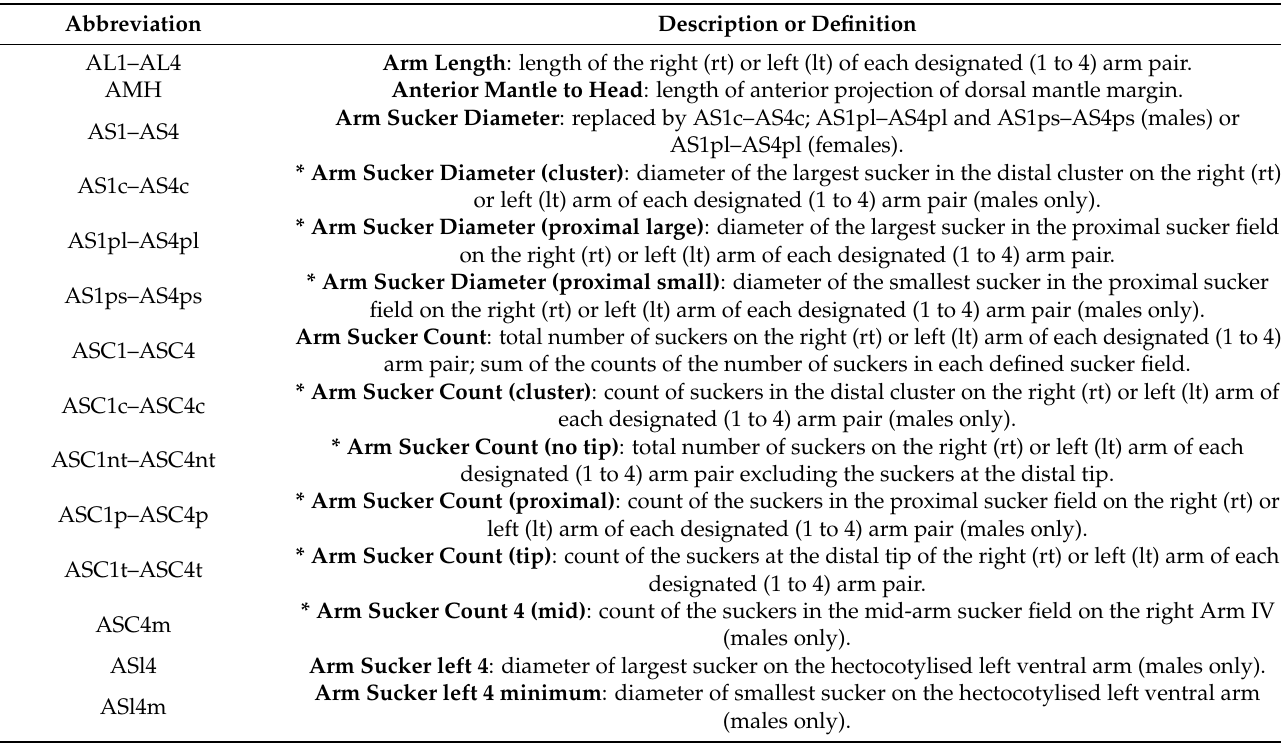
Table A1. Measurements and counts used in this study. An asterisk (*) denotes measurements or counts defined here for the first time, other definitions follow Refs [2–4]. See Description for details of the various sucker fields on the arms. TW in gm. AMH, FIa, P1 and all sucker diameters to